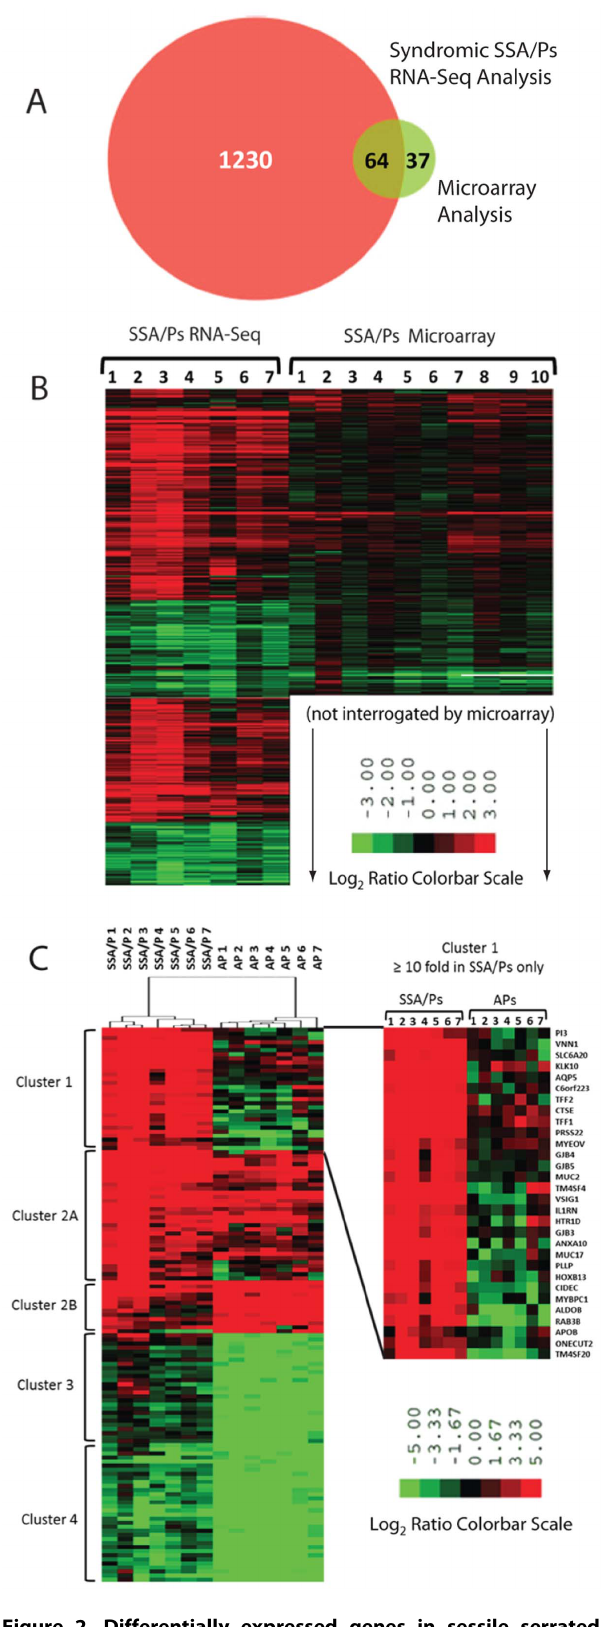
Figure 2. Differentially expressed genes in sessile serrated adenoma/polyps (SSA/Ps) by RNA sequencing (RNA-seq) and microarray analyses. Panel A . RNA-seq analysis identified